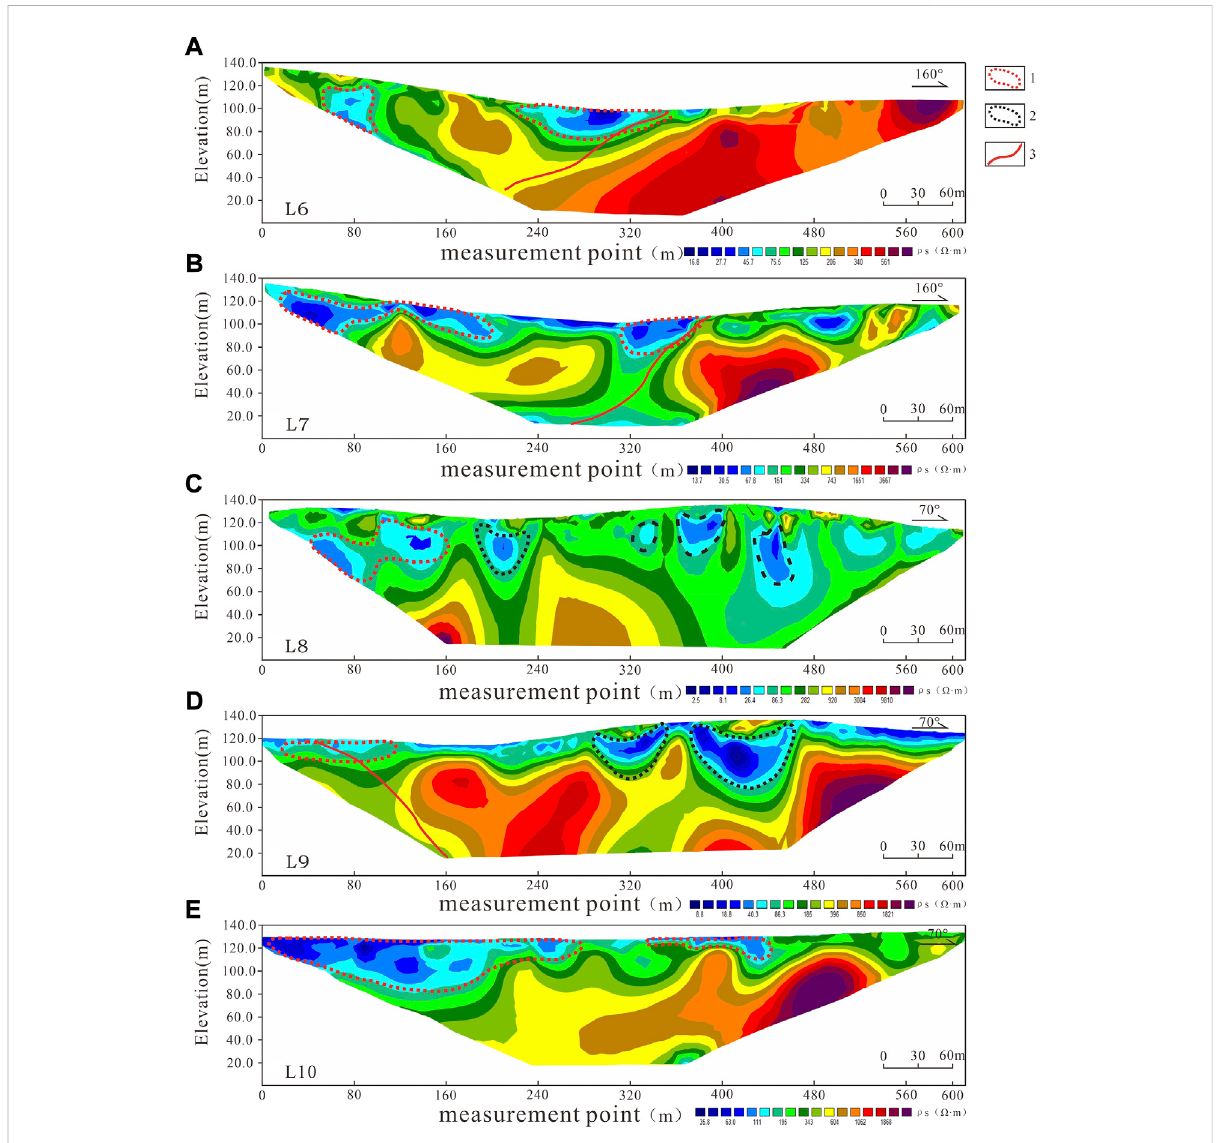
FIGURE 8 Geophysicalinversionsection(linesL6 – L10, A – E )ofthehigh-densityresistivitymethod.1,inferredscopeofkarst;2,inferredscopeofcollapse; 3, inferred line of